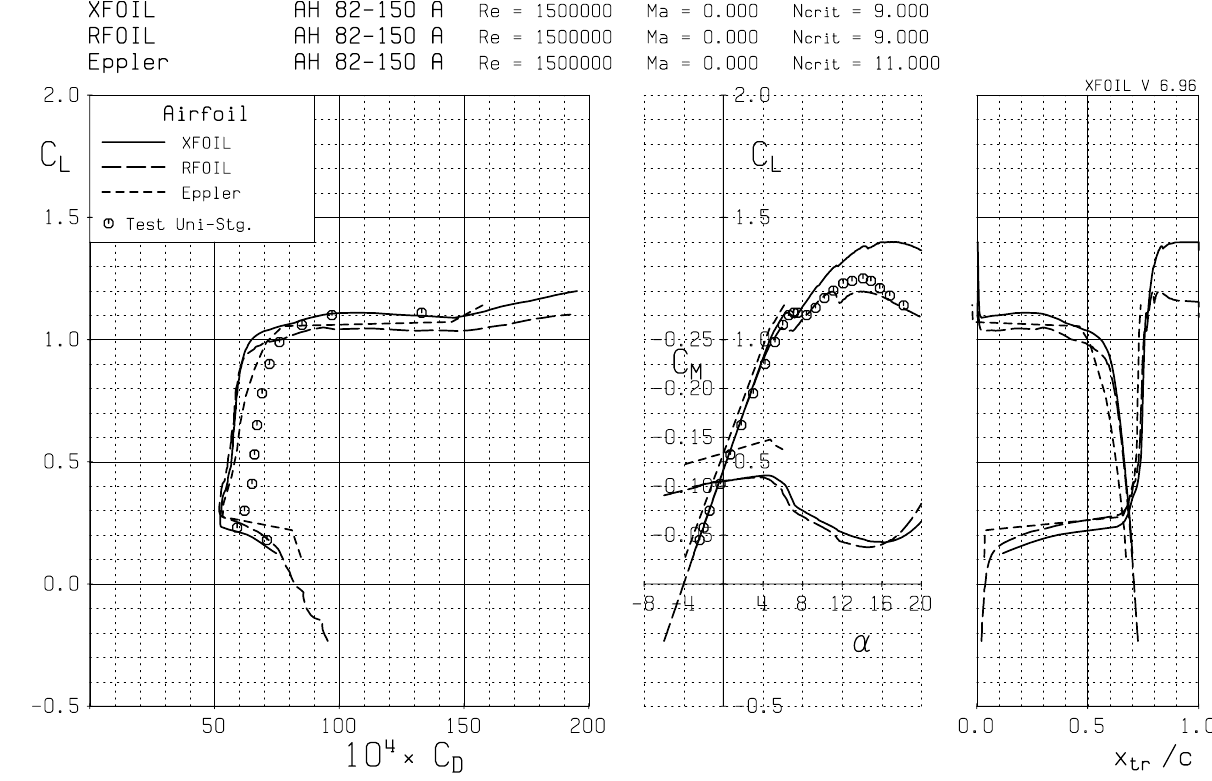
Fig 11. Comparison of calculated and measured data of AH82-150A airfoil at Re = 1.5·10 6